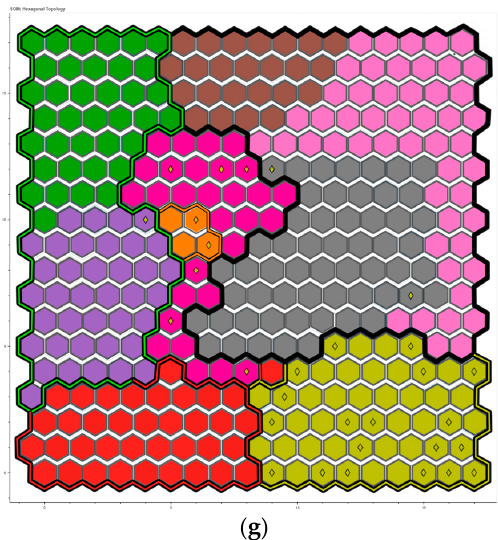
Figure 15. Output map for level 1 and level 2 anomalies samples. ( a ) Anomalies 3 L1, L2; ( b ) anomalies 5 L1, L2; ( c ) anomalies 6 L1, L2; ( d ) anomalies 7 L1, L2; ( e ) anomalies 8 L1, L2; ( f ) anomalies 9 L1, L2; ( g ) anomalies 10 L1, L2. The color legend can be consulted in Table 4. The green circles in Figure 15a represent the level 1 and 2 anomaly readings gener- ated by the VM3 shut-off valve. The new input data are arranged in four distinct clusters. The first two clusters are projected close to the border of the green area and the edge of the orange-coloured steady state. The readings of the first two levels of VM3 are similar to those of these two clusters. The last two clusters represent the readings of level 2. They are placed within the area of the reservoir anomaly since the system in both situations has the same incoming water flow rate.